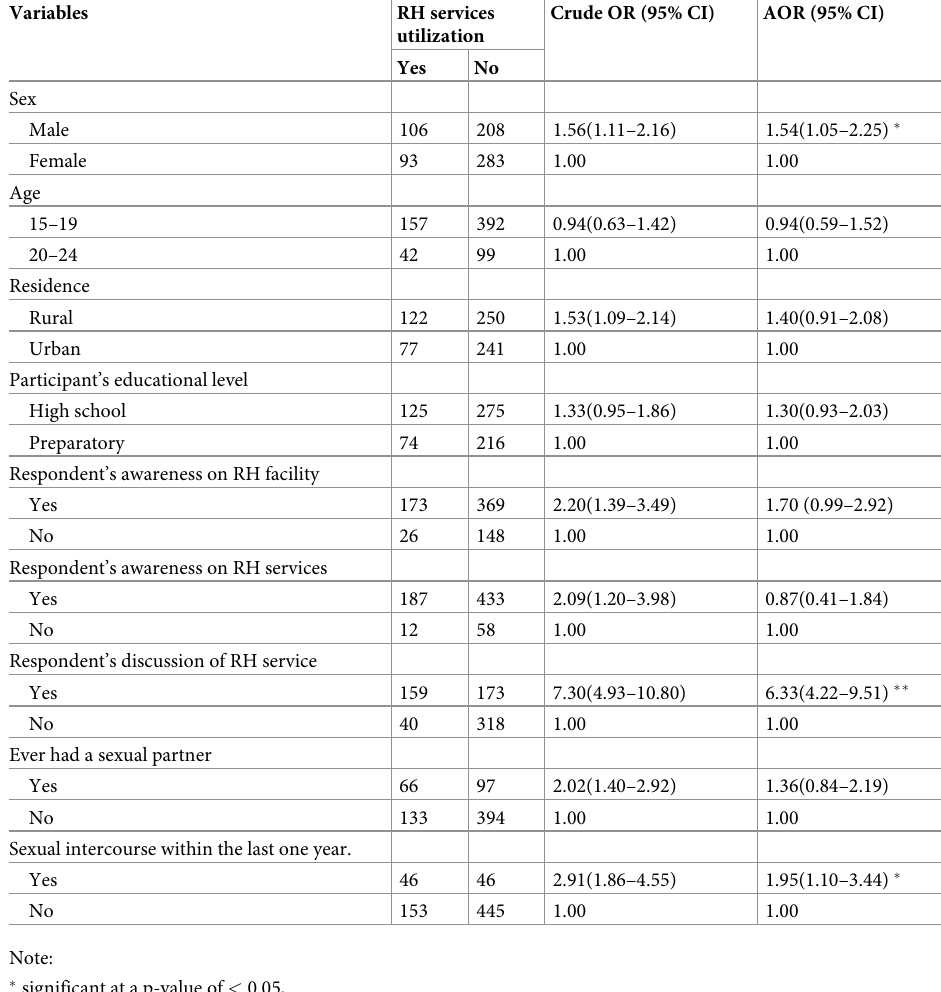
Table 4. Factors associated with reproductive health service utilization among high school and preparatory stu- dents in Debre Tabor town, Northwest Ethiopia, 2016.